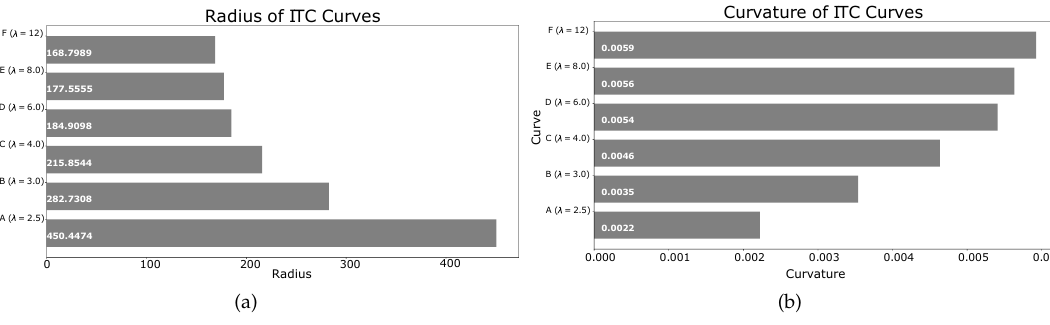
Figure 24. Radius and curvature of curves corresponding to different λ in Figure 23. ( a ) radius of curves at different points; ( b ) curvature of curves at different